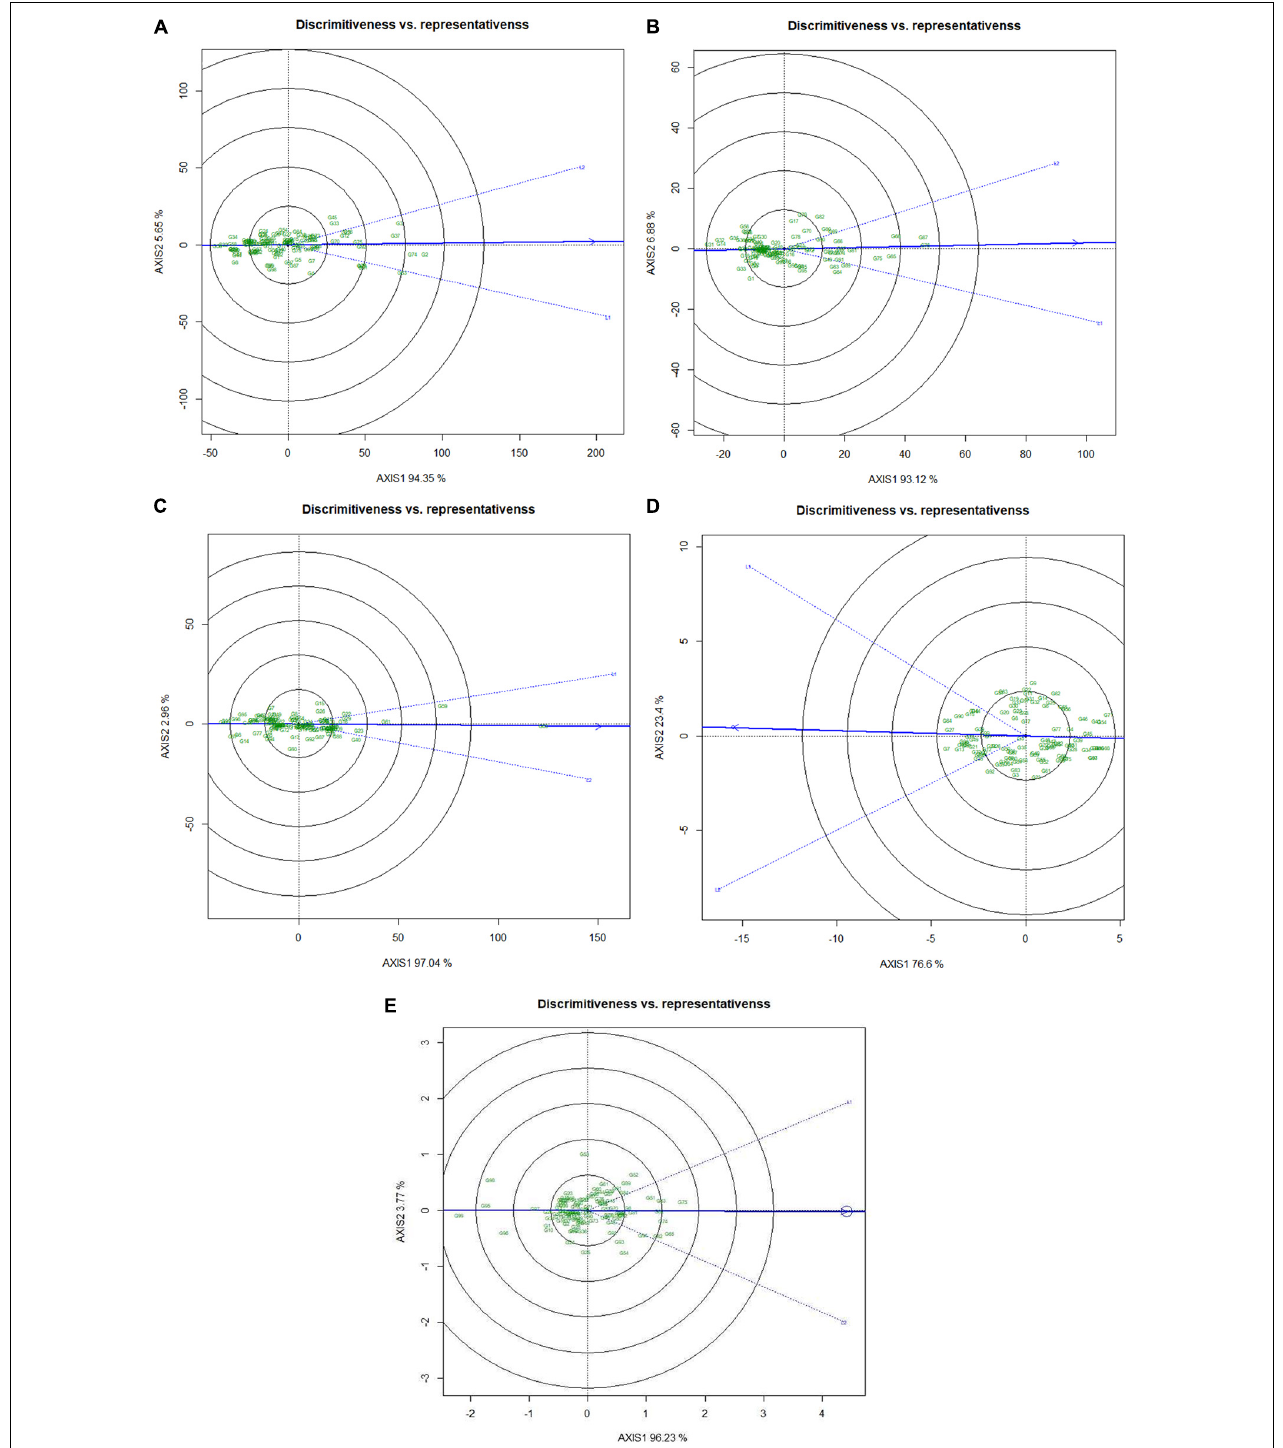
FIGURE 6 | “Discrimitiveness vs. representativeness” view of test locations based on GGE biplot across two testing locations. There was no transformation of data (transform = 0), and data were centered by means of the environments (centering = 2). The biplot was based on ‘row metric preserving.’ Numbers denote serial numbers of genotypes as listed in Supplementary Table S1 . (A) Discrimitiveness vs. representativeness view of test locations regarding Fe concentration. (B) Discrimitiveness vs. representativeness view of test locations regarding Zn concentration. (C) Discrimitiveness vs. representativeness view of test locations regarding Ca concentration. (D) Discrimitiveness vs. representativeness view of test locations regarding protein concentration. (E) Discrimitiveness vs. representativeness view of test locations regarding phytate concentration.